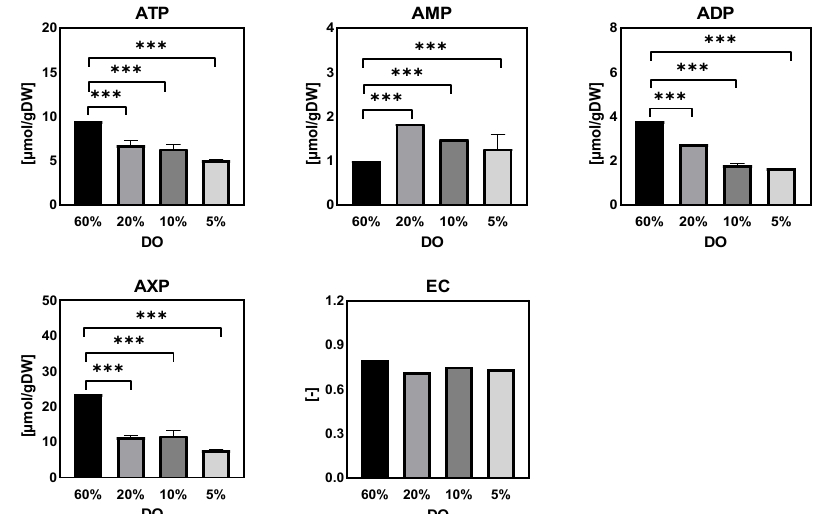
Figure 6. Intracellular amounts of adenine nucleotides and the energy charge in Penicillium chryso- genum Wisconsin 54-1255 under steady-state dissolved oxygen (60%, 20%, 10%, and 5%) conditions. Samples were collected at 24 h intervals and data were collected from three replicate experiments; Two-tailed Student’s t -tests ((***) p < 0.001) were performed using GraphPad Prism 8.